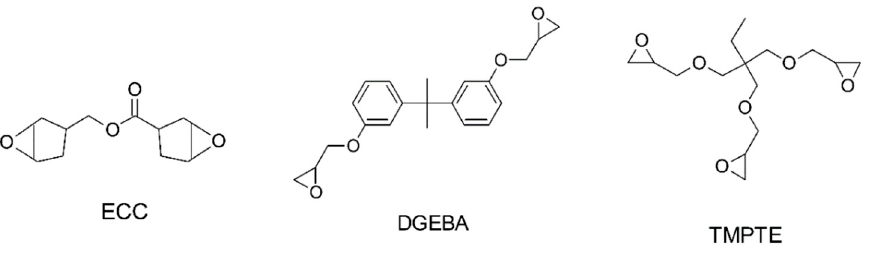
Figure 19. Structure of epoxy monomers commonly used for vat photopolymerization 3D printing.